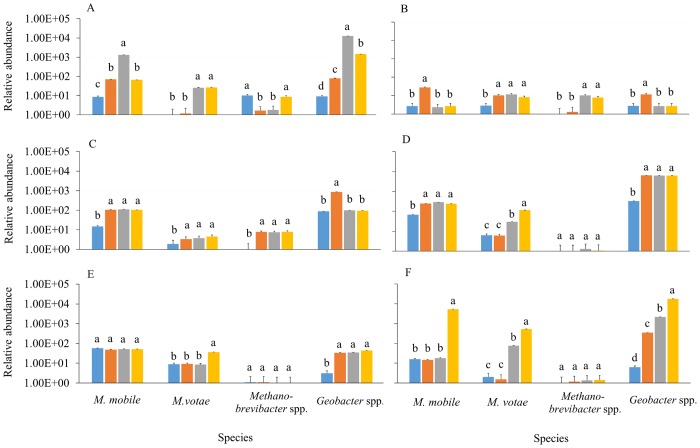
Relative abundance of different species of microorganisms in different parts of the digestive tract of calves during the first four days after birth.The abundance of Methanomicrobiales mobile, Methanococcales votae, Methanobrevibacter spp. and Geobacter spp. was determined in (A) rumen fluid, (B) rumen tissue, (C) abomasum, (D) cecum fluid, (E) cecum tissue, and (F) feces of calves of 0 days old (blue bars), 1 day old (orange bars), 2 days old (grey bars), and 3 days old (yellow bars). Abundance, as Log10 copy number per μl of 16S ribosomal DNA, is expressed relative to the lowest value among all species. Data are means ± SEM (n = 3). For each species, data without a common letter are significantly different (ANOVA, P < 0.05). Note the logarithmic scale of the y-axis.